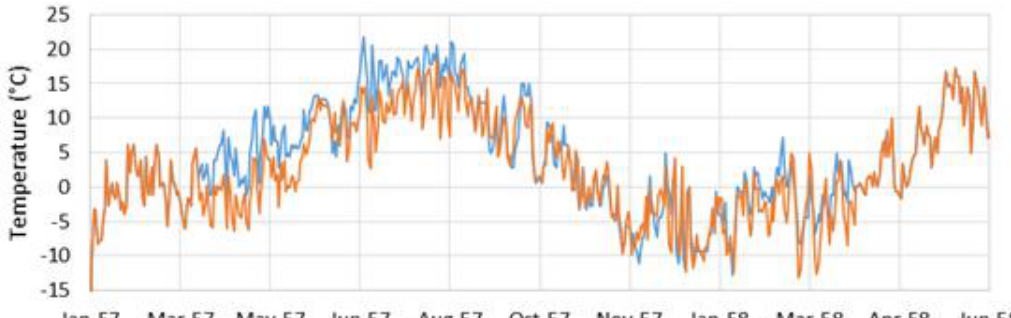
Figure 7. Results from the first realization of data imputation over a 365-day (1-year) gap. As in Figure 5, the imputed data match the seasonal variation and do a good job of matching shorter term fluctuations. There are two periods, one in May and one in June, where the imputed data over-predict the temperatures, but overall the fit is remarkably good for such a long gap.